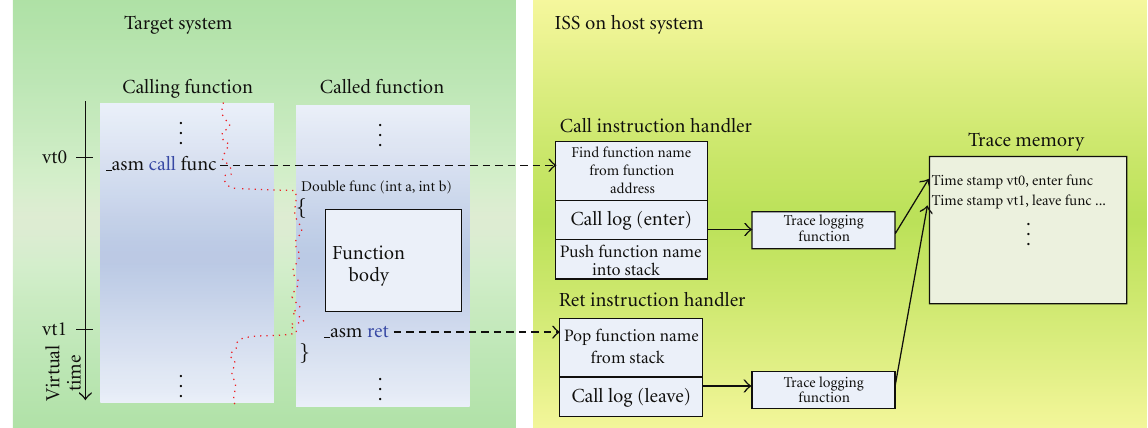
Figure 5: Transparent instrumentation method.